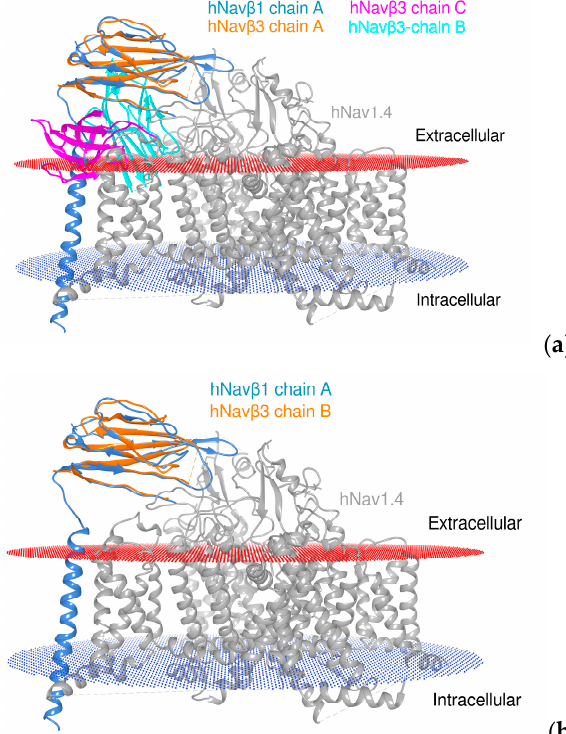
Figure 8. Superposition of monomeric and trimeric 3D models of β proteins. ( a ) Experimentally determined homotrimeric hNa v β 3 [55] (three colors: magenta, light blue, beige) in superposition with template hNa v 1.4 / hNa v β 1 (bluish / grey) [49] and ( b ) one IgD (out of three) subunit(s) of homotrimeric hNa v β 3 (beige) in superposition with template hNa v 1.4 α / hNa v β 1. It can be seen—by eyesight—that in case a two out of the three subunits bump into the membrane. Extracellular membrane boundaries: dark red; intracellular membrane boundaries: navy blue; Na v α subunit: gray; hNa v β 1 subunit: cornflower blue; hNa v β 3 chains A, B, and C: orange, cyan, and magenta, respectively.